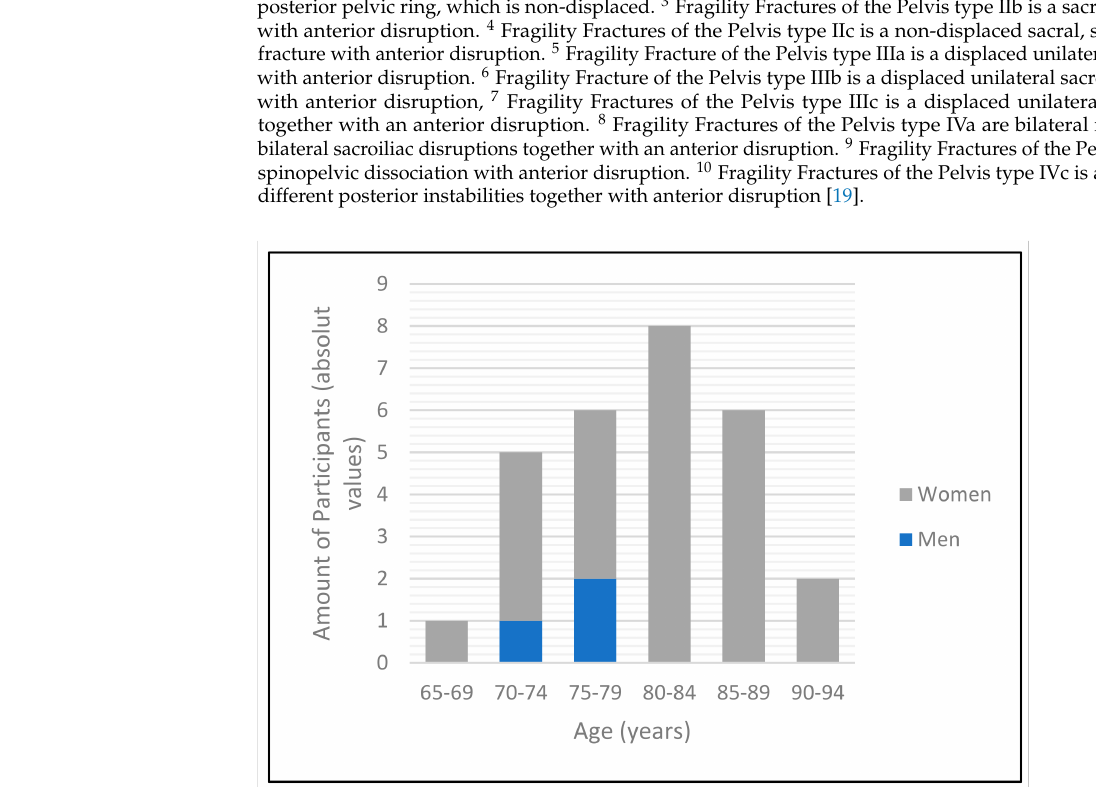
Figure 3. Bar diagram representing the distribution of gender and age within the study cohort. Of the patients admitted, 21 presented with a unilateral fracture (75.0%). Seven patients presented with bilateral fractures. 15 incurred an FFP II (53.6%), 6 an FFP III (21.4%) and only 7 an FFP type IV fracture (25.0%). Of these 28 fractures treated, 5 followed a conscious trauma (17.9%) and 17 were considered to have insufficiency fractures for which no relevant trauma was recalled (60.1%). In 6 cases (21.4%), it could not be determined retrospectively whether the fracture occurred due to trauma or not (Table 1, Figure